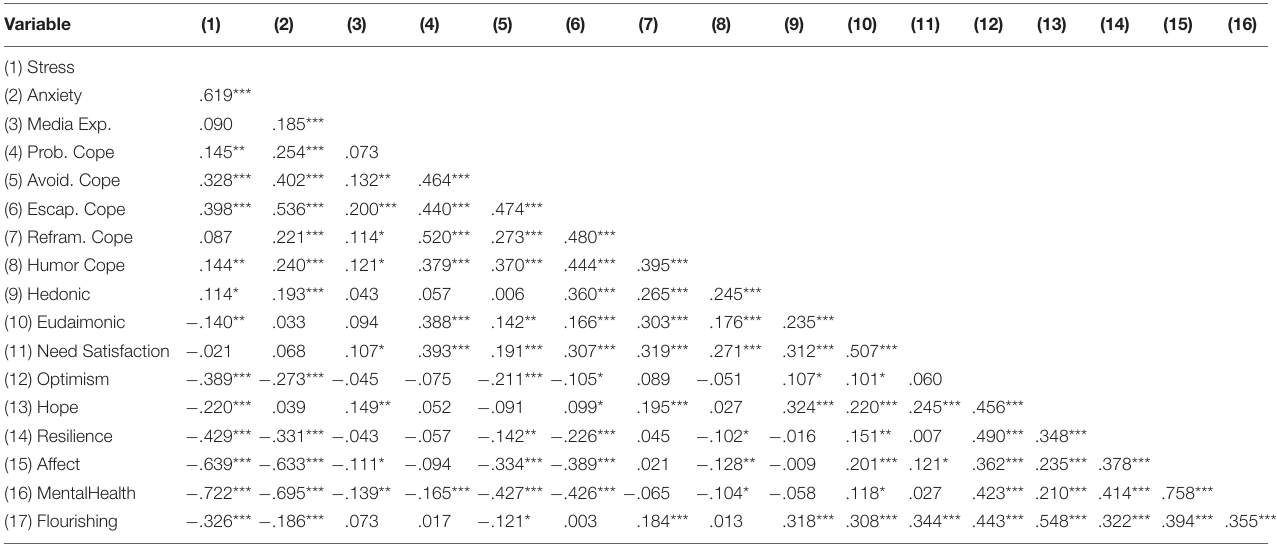
TABLE 3 | Correlations among study variables.